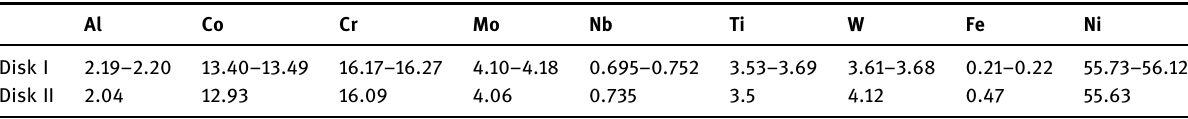
Table 2: Composition of René 65 sample disks ( %